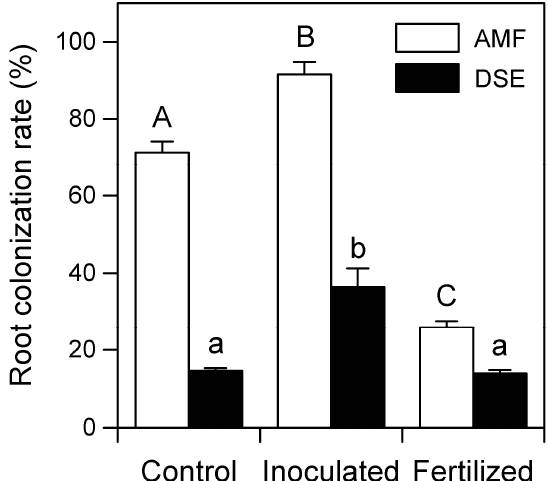
Figure 3. Colonization rates (%) of arbuscular mycorrhizal fungi (AMF, open bars) and dark septate endophyte (DSE, filled bars) on Eragrostis tef roots in cropland soil (Control), cropland soil inoculated with forest soil (Inoculated) and after N-P fertilisation (Fertilized). Different capital/small letters indicate significant differences between treatments; values are the average of three soil types of five replicates each (TukeyHSD, p < 0.05, n = 15; mean + SE).